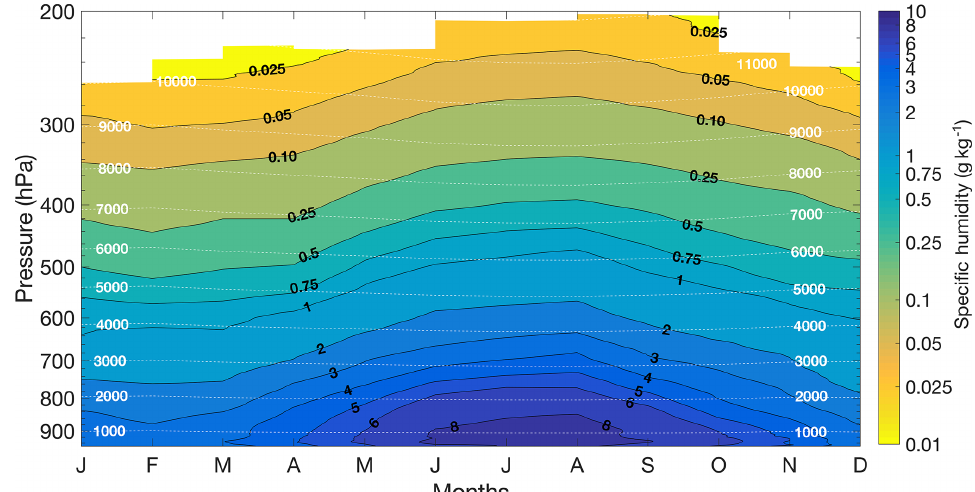
Figure 2. The monthly climatology for tropospheric water vapour from RALMO in units of specific humidity (gkg − 1 ). Contours for specific humidity are labelled in bold black. Dashed white lines are the average altitudes for each pressure level and are in units of metres. Larger amounts of water vapour are seen in the summer months due to higher temperatures. The lowest pressure is 250hPa during the summer months. In the winter, the lowest pressure is 280hPa due to the lower water vapour content. Higher water vapour content is shown in darker blue colours and lower water vapour content in lighter